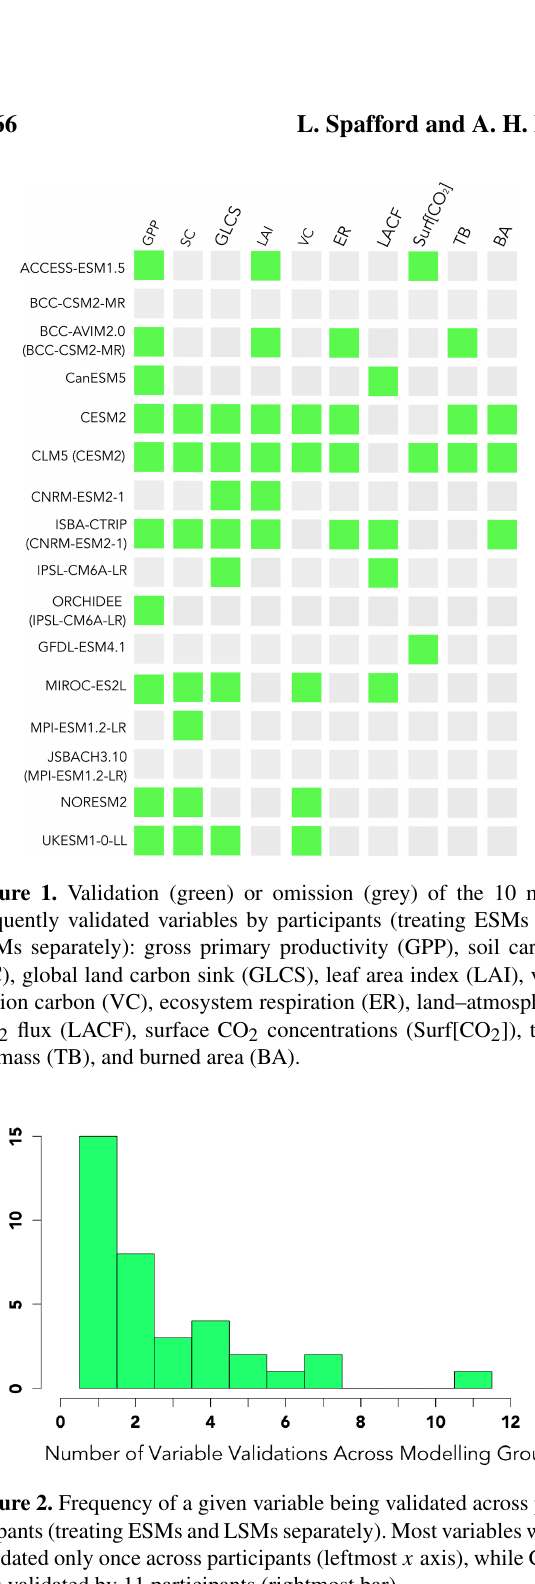
scales included daily, seasonal, annual, decadal, select pe- riods, and long-term trends, accumulations, or averages over the whole historical simulation period from 1850 to